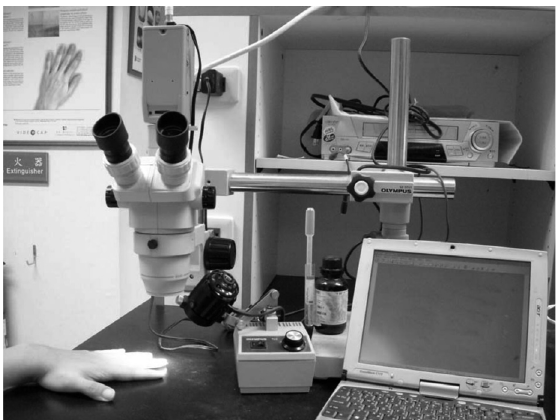
Fig.4. The present nailfold capillaroscope in authors ’ hospital (Olympus